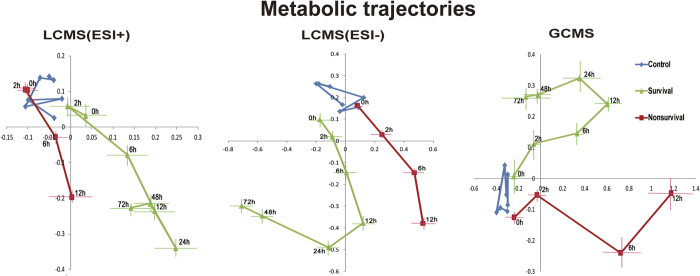
The time-dependent trajectory of the metabolic profiles of the control and the LPS groups.Each dot represents the average metabolic status at a certain time; bar lines indicate the SEs of PC1 and PC2 in the PCA model.